Question: In a single sentence, describe what this figure presents.
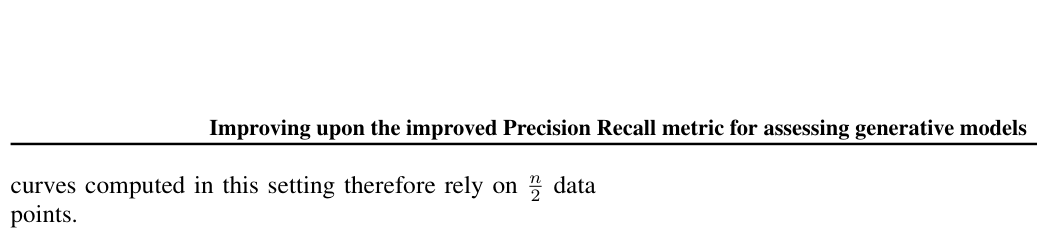
Answer: provides a visual illustration of the practical impact of splitting the dataset into separate training and validation sets to assess precision-recall curves. We consider same experimental setting as in section 4.1 and Figure 2 with µ = 0, in such a way that P = Q. In this specific case, the precision is equal to 1 for all recall.